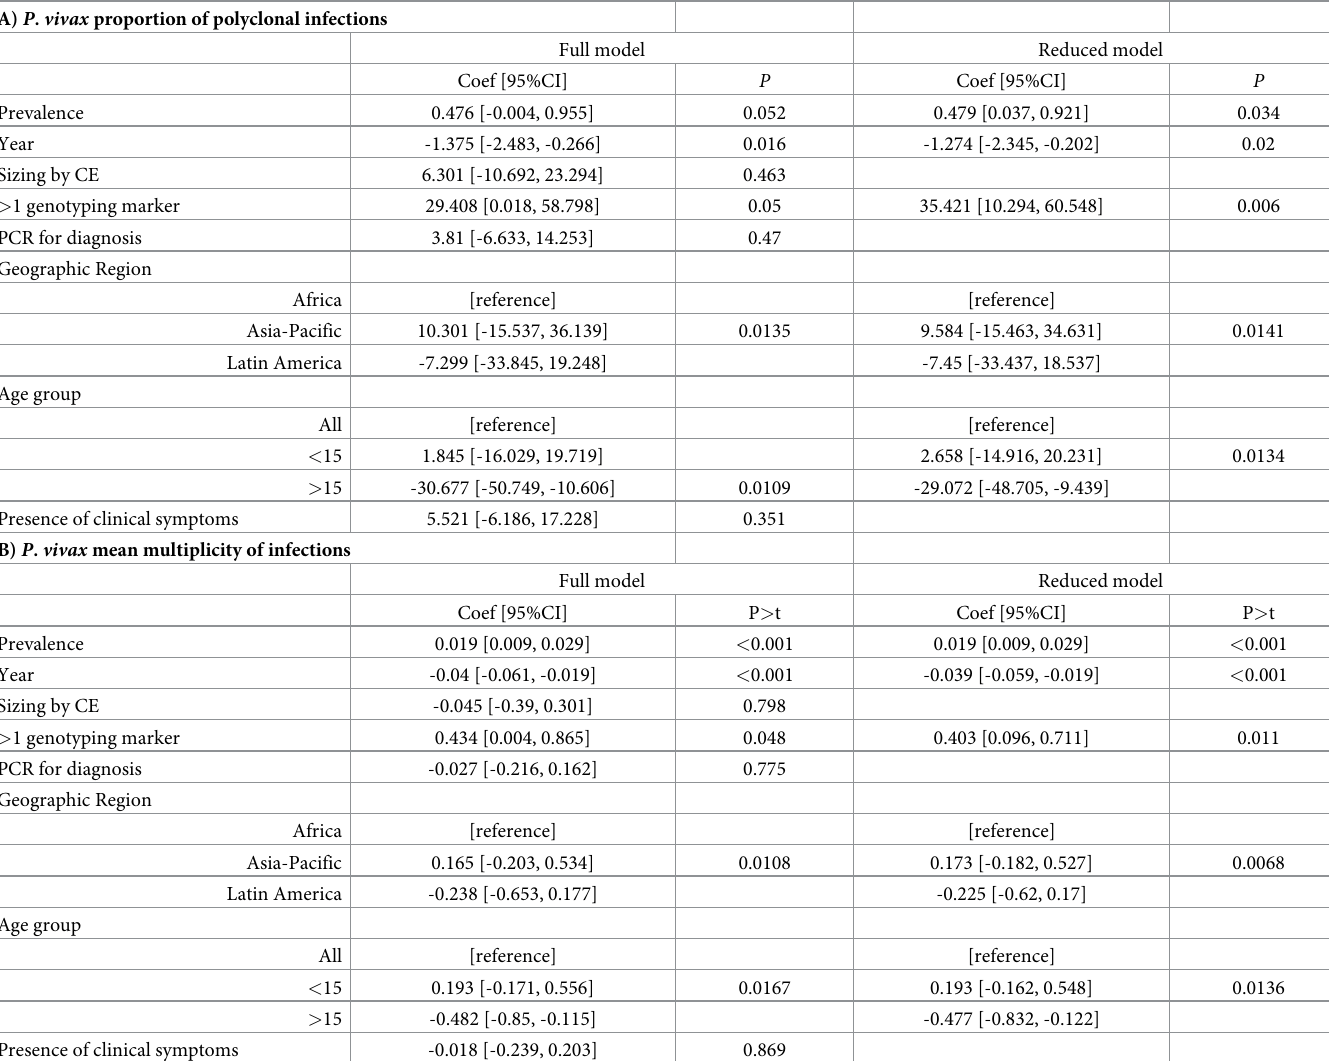
Table 3. Multivariable predictors of A) P . vivax proportion of polyclonal infections, and B) mean multiple clone infections. 95%CI = 95% confidence interval. A) P . vivax proportion of polyclonal